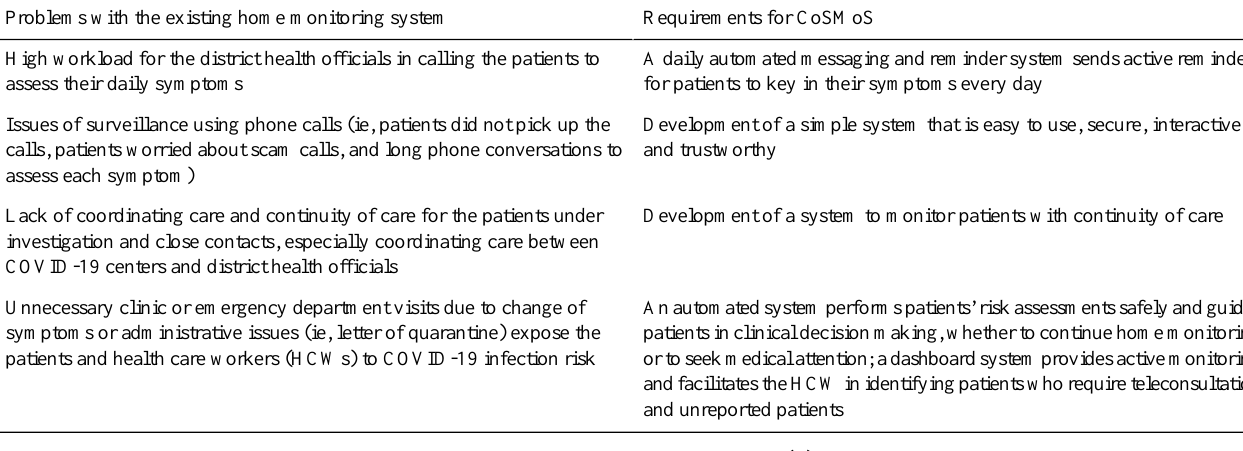
Table 1. Problems identified with the existing home monitoring system and proposed requirements for the COVID-19 Symptom Monitoring System